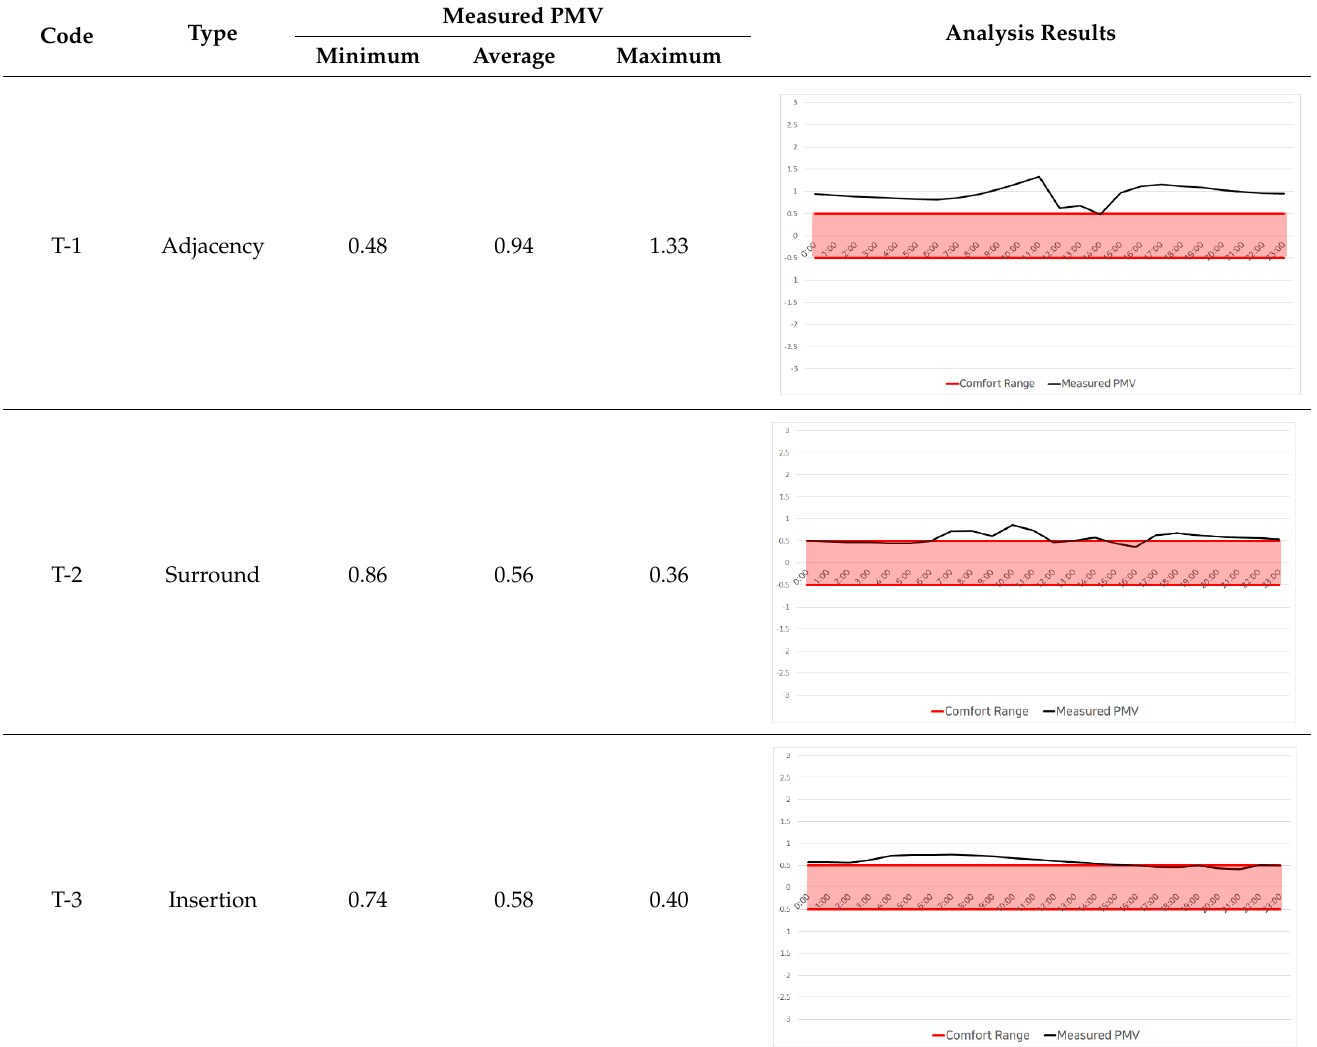
Table 5. Measured hourly PMVs for target Hanoks.